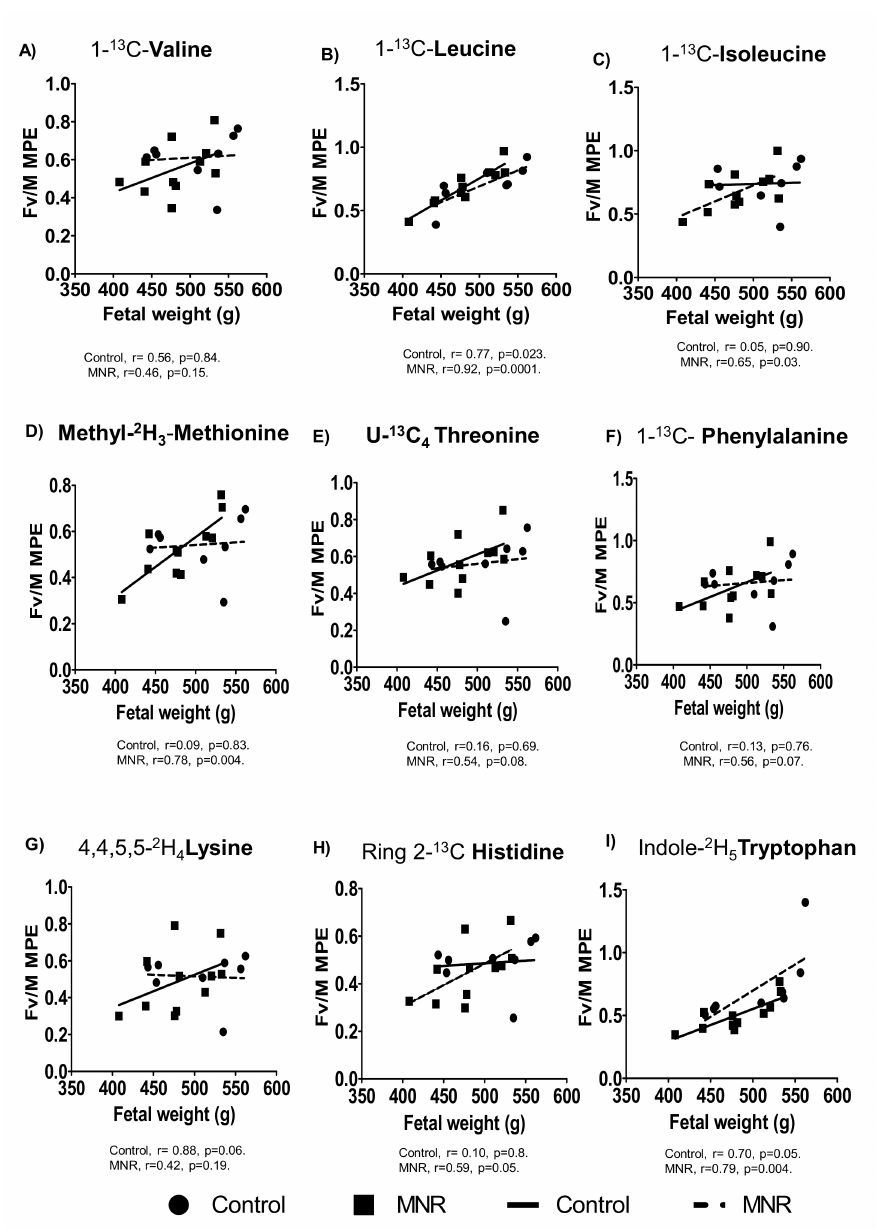
Figure 4. Relationship between Fv/M MPE ratio and fetal weight. ( A – I ) Correlation between fetal vein/maternal artery (Fv/M) mole percent excess (MPE) ratio of (1- 13 C) valine, (1- 13 C) leucine, (1- 13 C) isoleucine, [Methyl- 2 H 3 ] methionine, [U- 13 C 4 ] threonine, [1- 13 C] phenylalanine, [4,4,5,5- 2 H 4 ] lysine, [Ring 2- 13 C] histidine, and [Indole- 2 H 5 ] tryptophan and fetal weight in control ( n = 8) and MNR ( n = 11) baboons at GD140. Pearson correlation coefficient